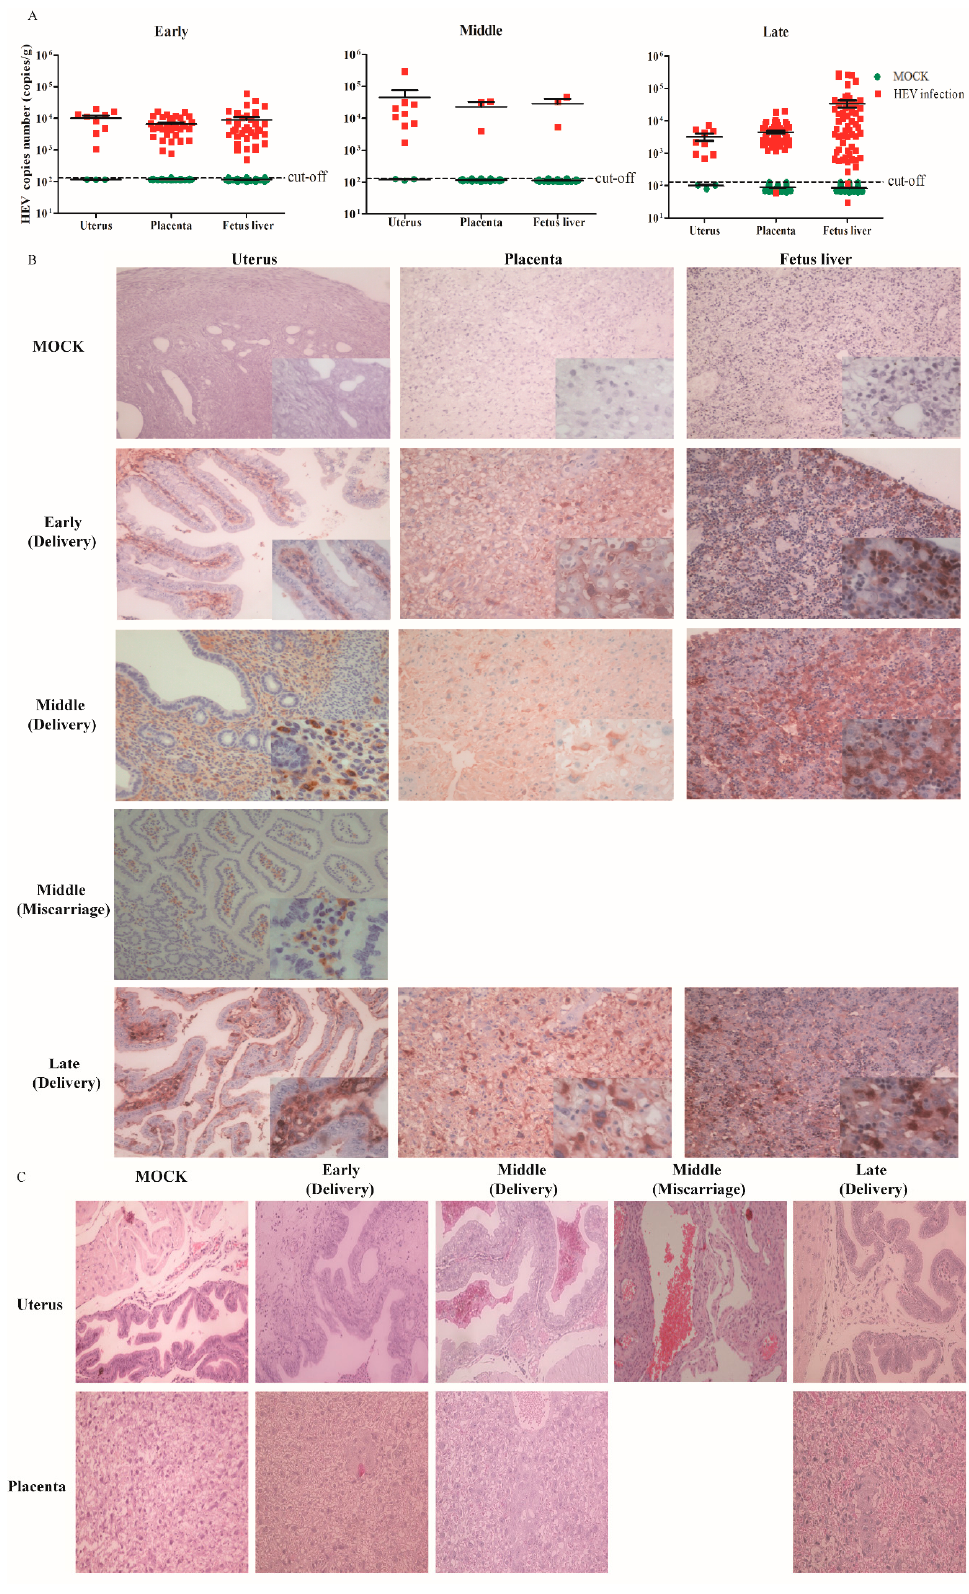
Figure 5. HEV vertically transmits from the mother to the fetus. ( A ) Viral titer in the uterus and placenta of HEV-infected pregnant mice or liver of fetuses. ( B ) HEV antigen analysis of the uterus, placenta and liver by IHC, × 20. ( C ) Histopathological analysis of the uterus and placenta of HEV-infected mice, ×